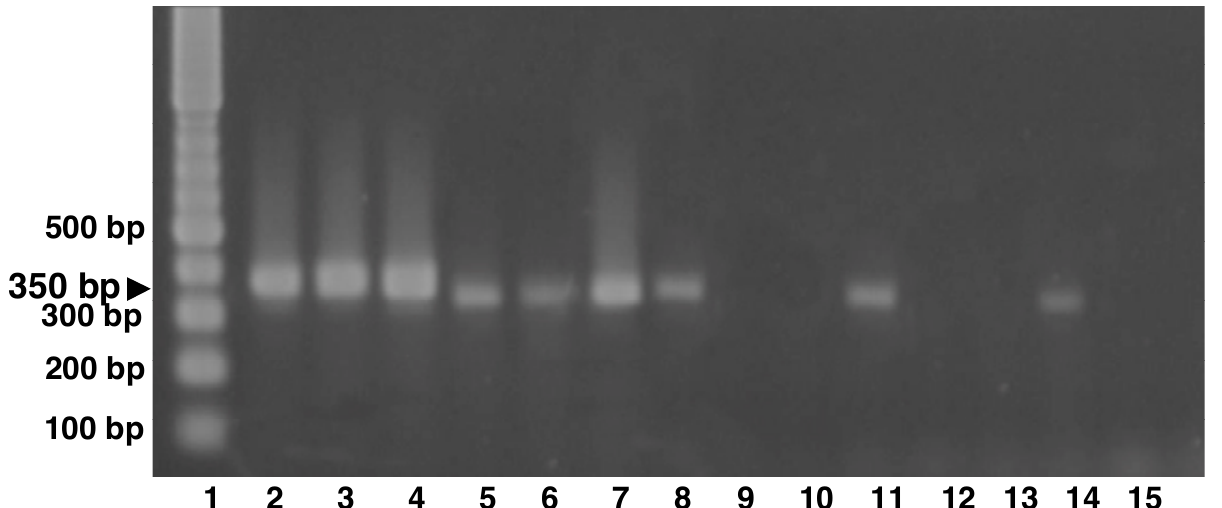
Figure 2. Agarose gel showing PCR products amplified from grapevine samples infected by GRSPaV. Lane 1, DNA ladder marker; lanes 1 to 13, tested grapevines samples (positive reactions in lanes 1‒8, 11); lane 14, positive control (vine infected by GRSPaV); lane 15, negative control (healthy vine